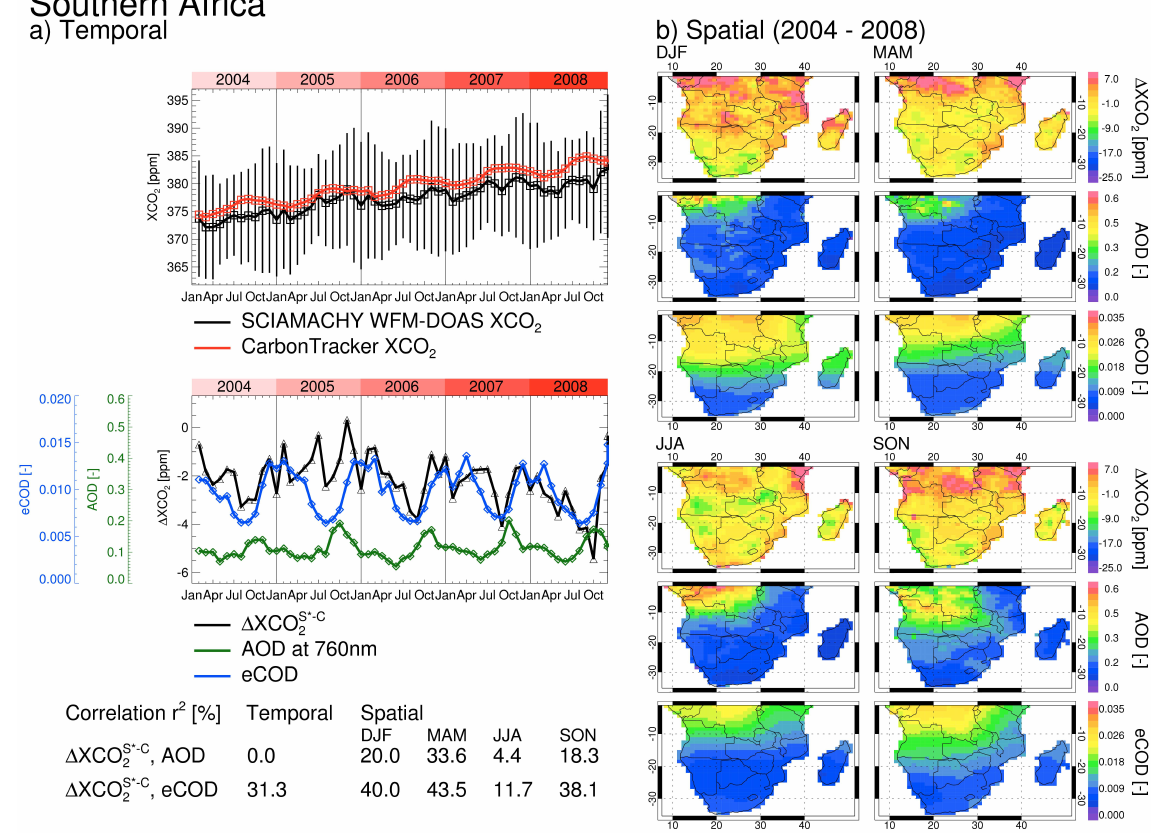
Fig. 12. As Fig. 11 but for Southern Africa.